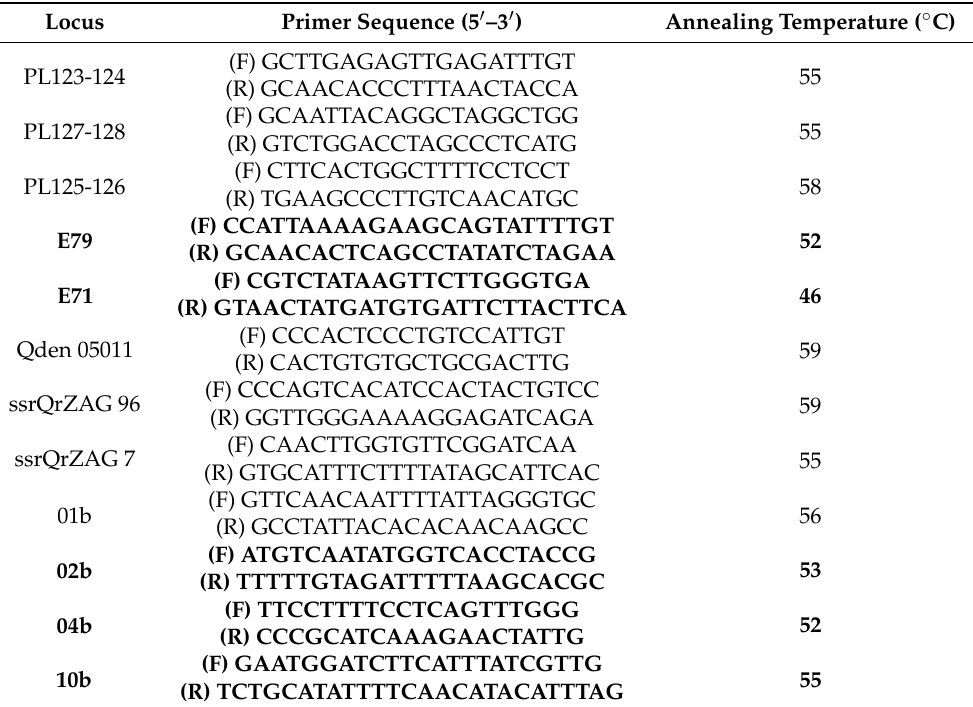
Table 1. Sequences and proper annealing temperature of 12 primer pairs. Locus Primer Sequence (5 (cid:48) –3 (cid:48)